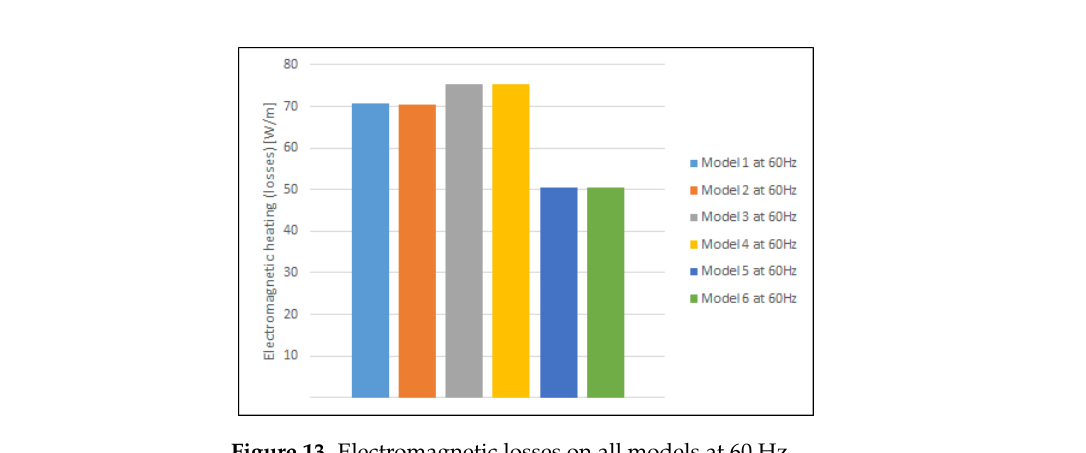
Figure 13. Electromagnetic losses on all models at 60 Hz.